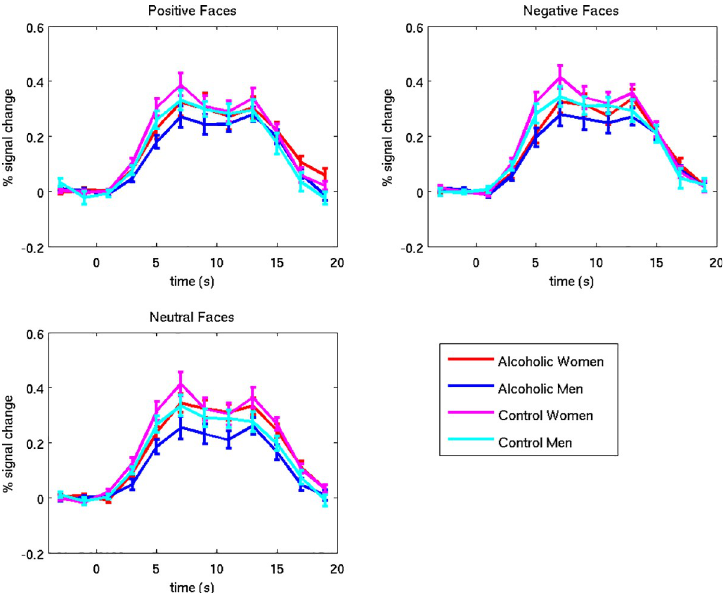
Fig 3. Left intraparietal sulcus. Error bars represent the standard error of the mean. The analysis window used to examine the encoded faces was 2 to 10 seconds. The first peak (at approximately 7 seconds) represents brain activity resulting from the encoded faces. The activity following that peak (longer than 10 seconds) shows responses to the distractor and probe stimuli, to be described in a future research report.